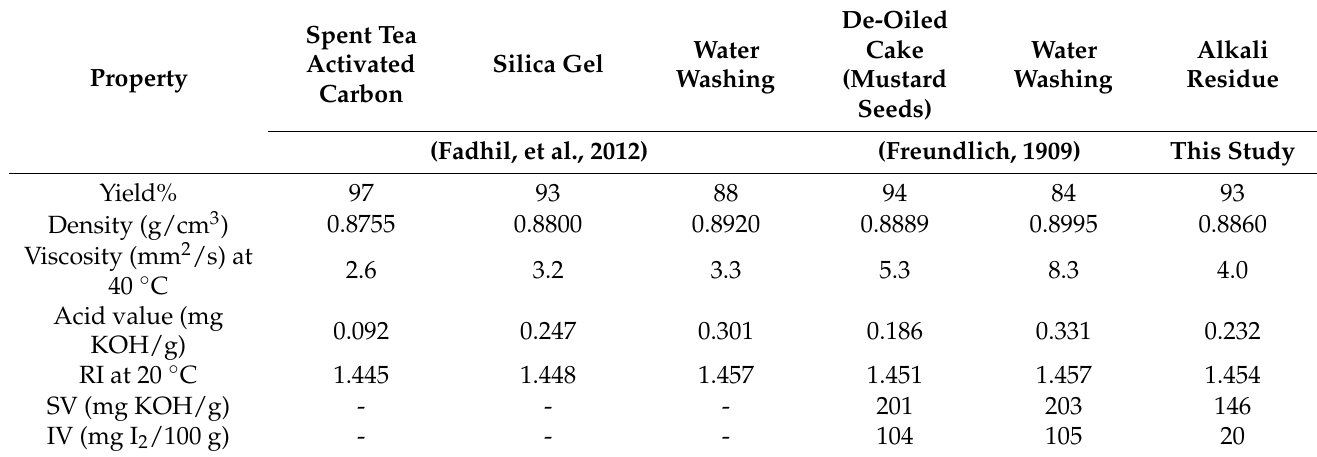
Table 3. Purified biodiesel properties using different bioadsorbents compared to water washing and the bioadsorbent in this